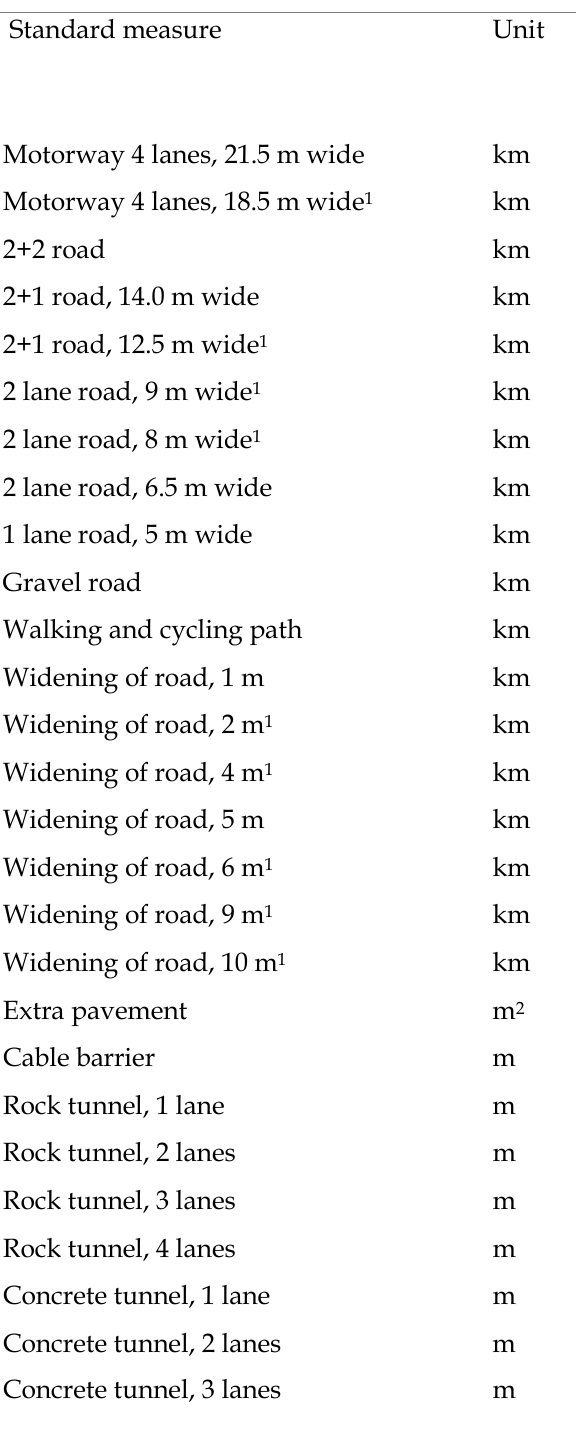
Table A1. New construction of road infrastructure during 1 year (arithmetic mean over the period 2010 – 2015): resulting inventory of standard measures (plain roads, tunnels, bridges, traffic junctions, roundabouts, wildlife fence, noise protection, soil stabilisation, and deforestation). Length of plain roads do not include roads constructed in tunnels and on bridges, since the standard measures for tunnels and bridges in Klimatkalkyl 4.0 include also construction of the